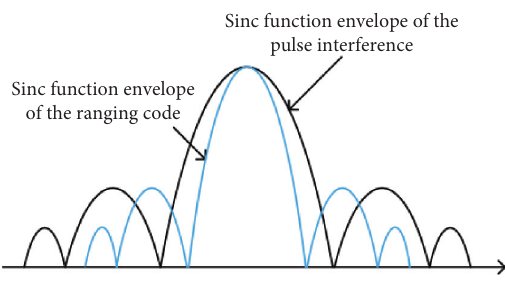
Figure 14: Sinc function envelope of pulse interference and ranging code spectrum line ( T